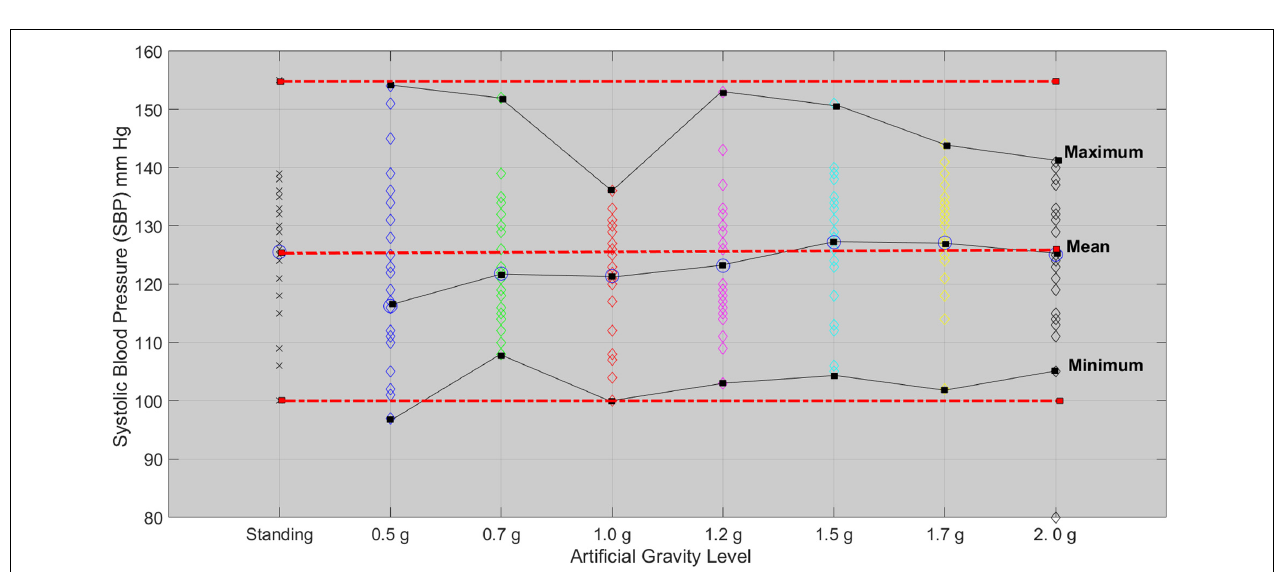
FIGURE 6 | Mean arterial pressure for each of the 24 participants in the standing position (red dotted line) and at each artificial gravity (AG) load (denoted with a diamond of a different color: blue, 0.5g; green, 0.7g; red, 1.0g; magenta, 1.2g; cyan, 1.5g; yellow, 1.7g; black, 2.0g).